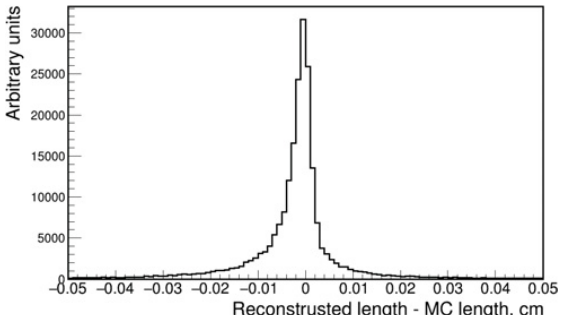
Figure 4. Distribution of track length difference. Typical track length inside a strip is about 1 cm.